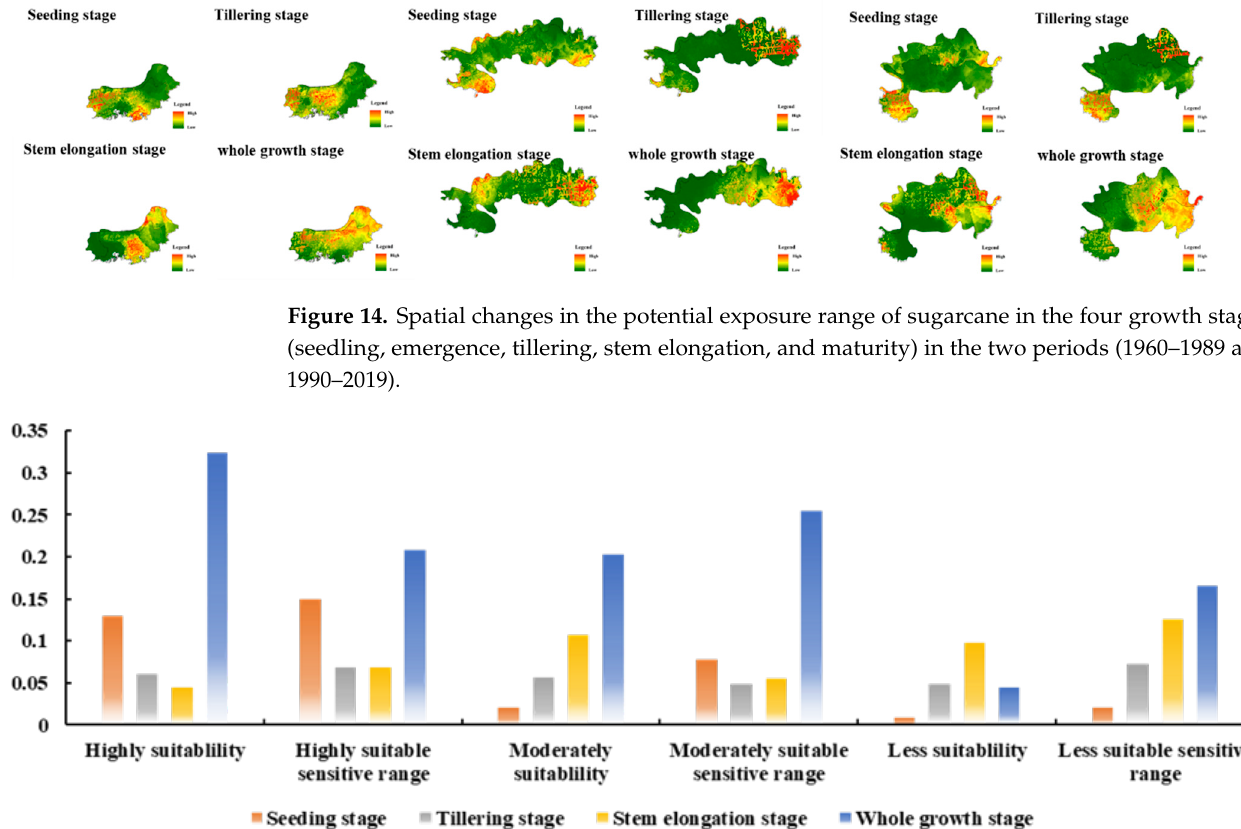
Figure 15. Changes in the risk value of the potential exposure area of sugarcane in the four growth stages (seedling, tillering, stem elongation, and maturity) in the two periods (1960–1989 and 1990– 2019).